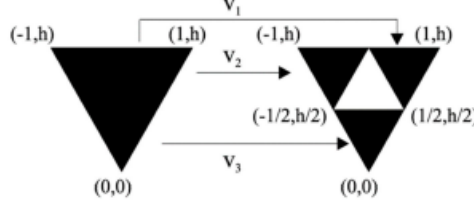
Figure 1. Modeling of fractal geometry [19].